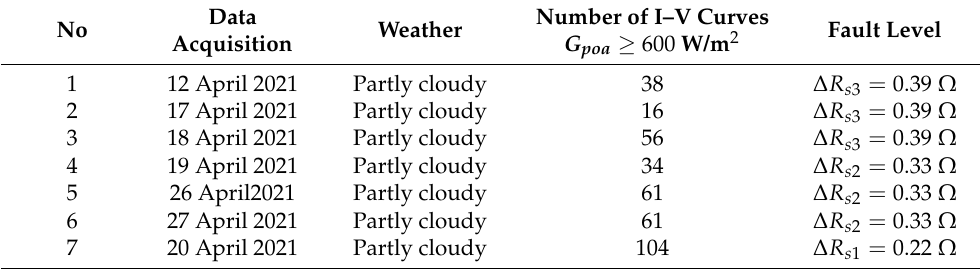
Table 14 . Data acquisition in case of 𝑅 (cid:3046) degradation.